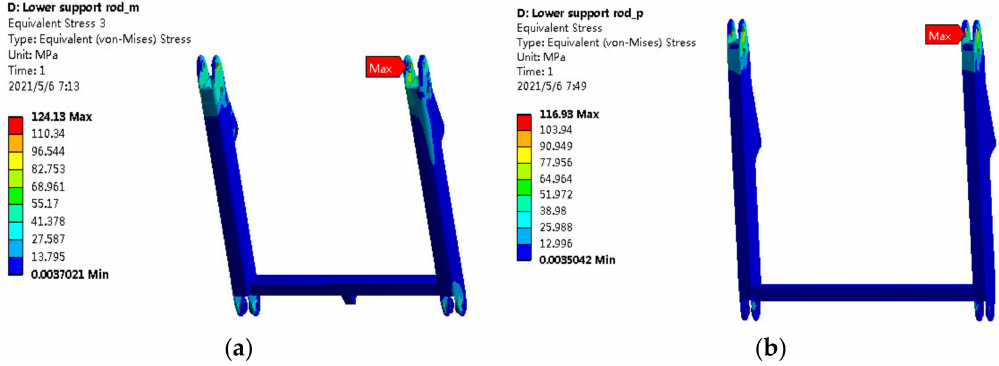
Figure 20. Stress distribution of support components under tensioner support. ( a ) Scaled model; ( b )